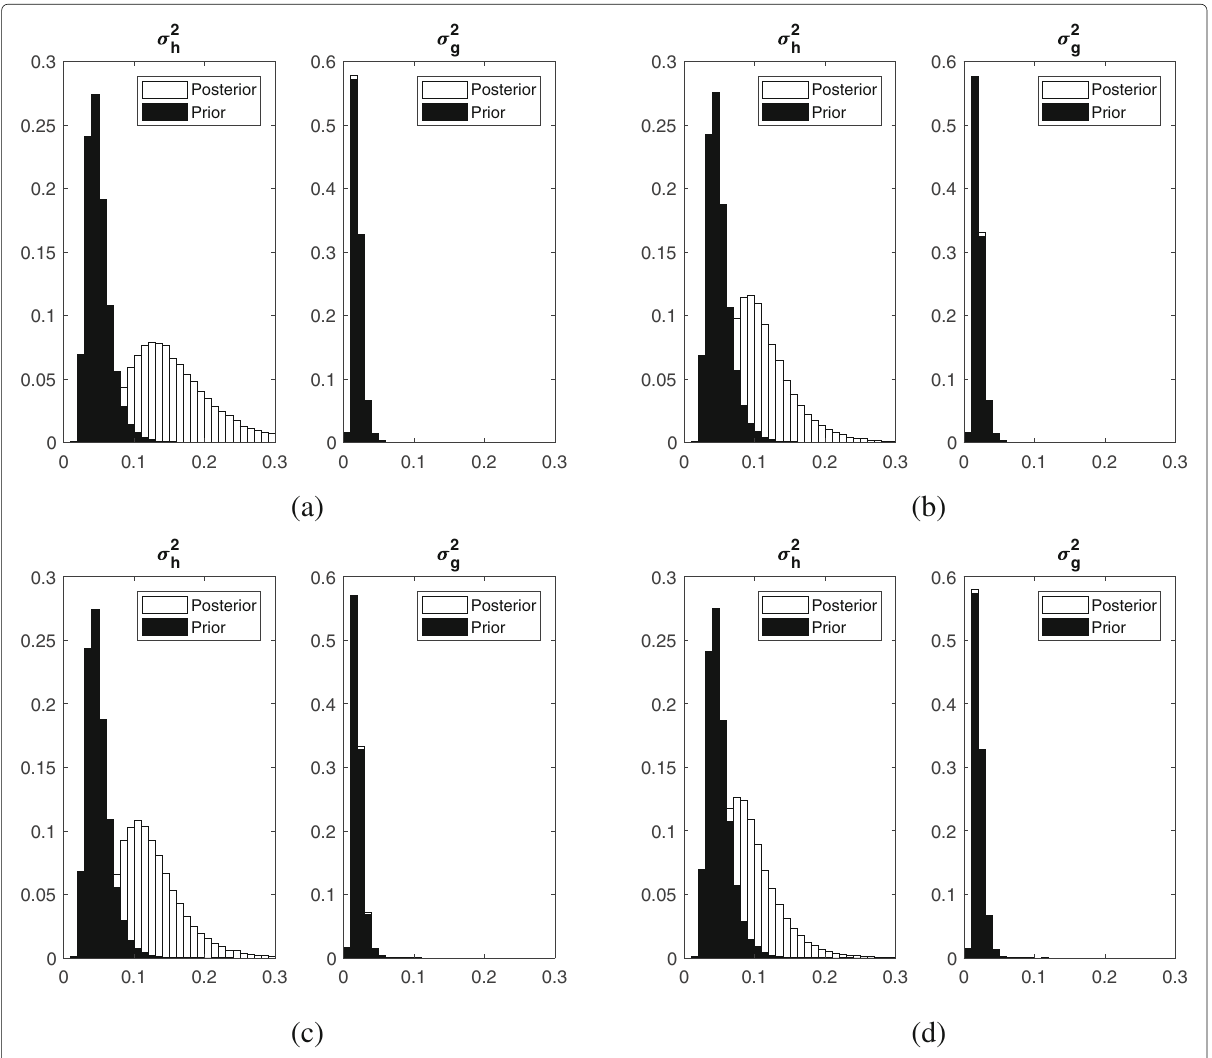
Fig. 6 Prior and posterior σ 2 , σ 2 g . Prior distribution (black bars) and posterior distribution (white bars) for the variance in the stochastic volatility h equation. a CPI. b WPI. c DEFL. d